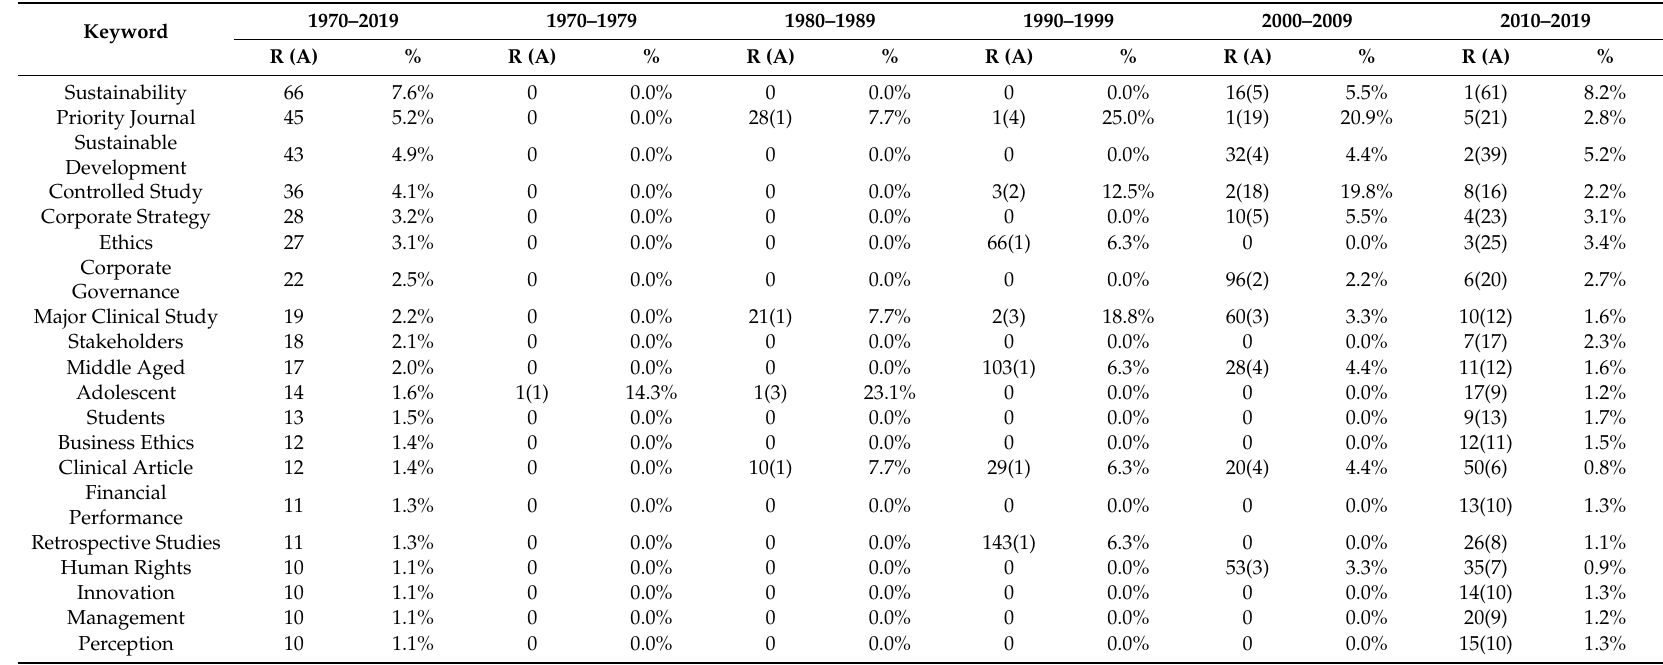
Table 9. Main keywords on USR research